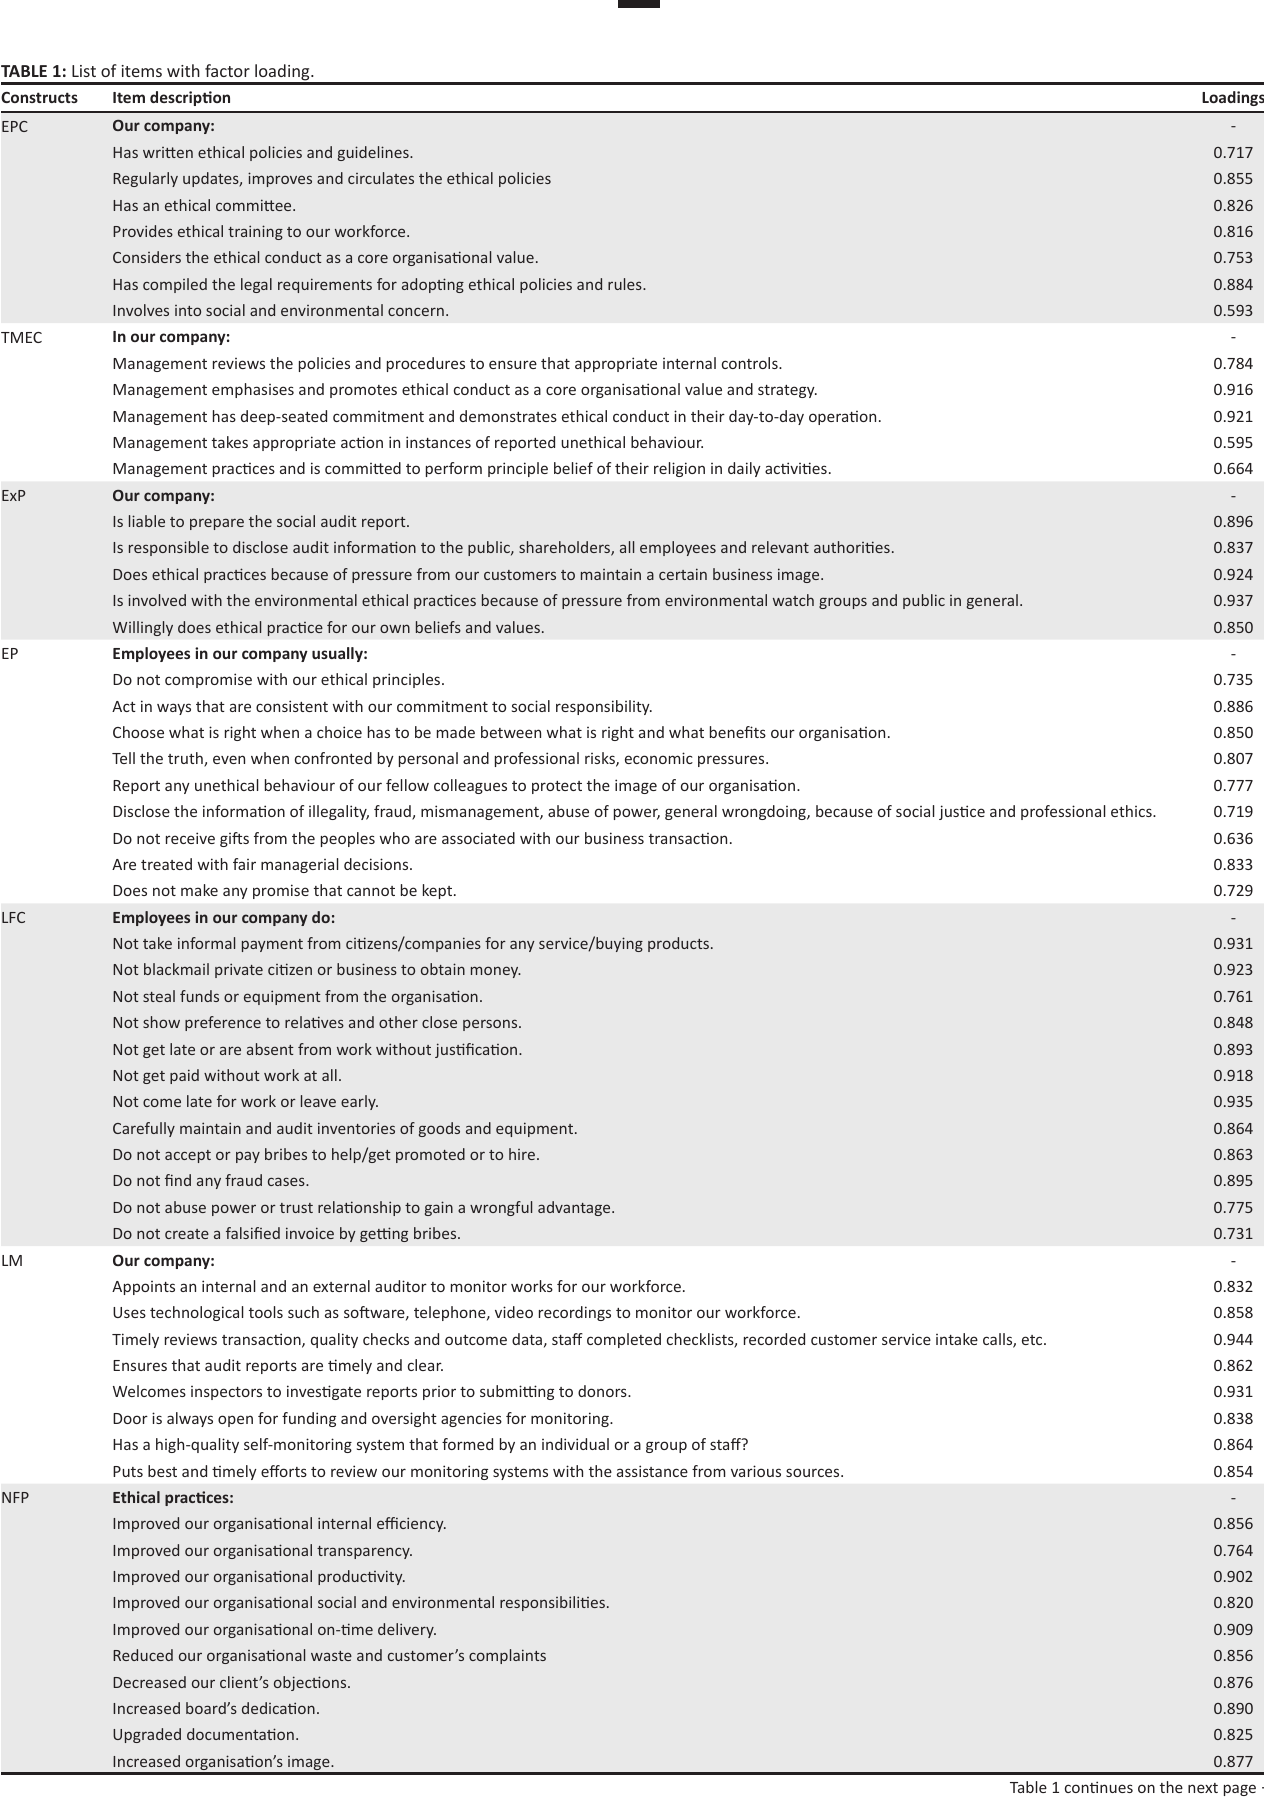
TABLE 1: List of items with factor loading.